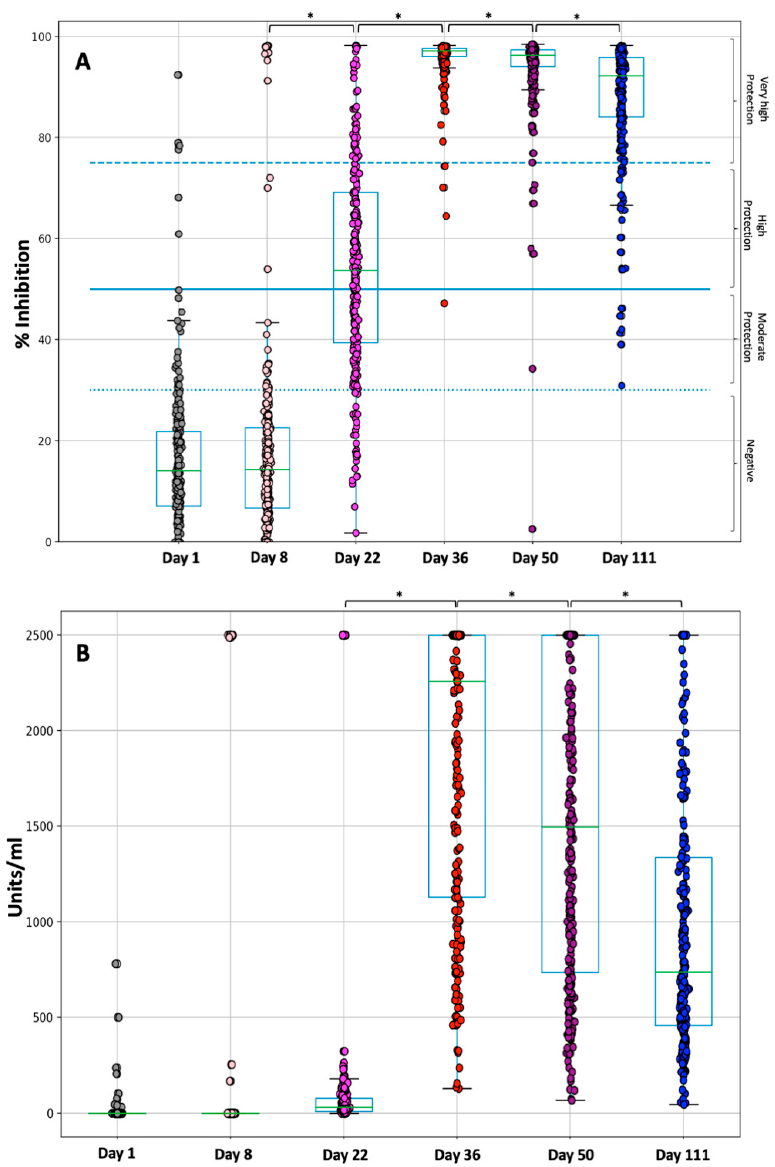
Figure 1. Inhibition (%) of SARS-CoV-2 binding to the human host receptor angiotensin-converting enzyme-2 ( A ) and anti-SRBD levels ( B ) after vaccination with the BNT162b2 mRNA vaccine. Anti- bodies were measured on D1 (vaccination date), D8, D22, D36, D50, and D111 (3 months after the second shot). Asterisks (*) indicate statistically significant differences ( p -value < 0.05) between the compared groups. The boxplot borders refer to the quartiles of the distribution, while the overlaid dots represent the individual values of NAb inhibition. Dashed lines refer to the borderline levels of inhibition i.e., 30%, 50%, and